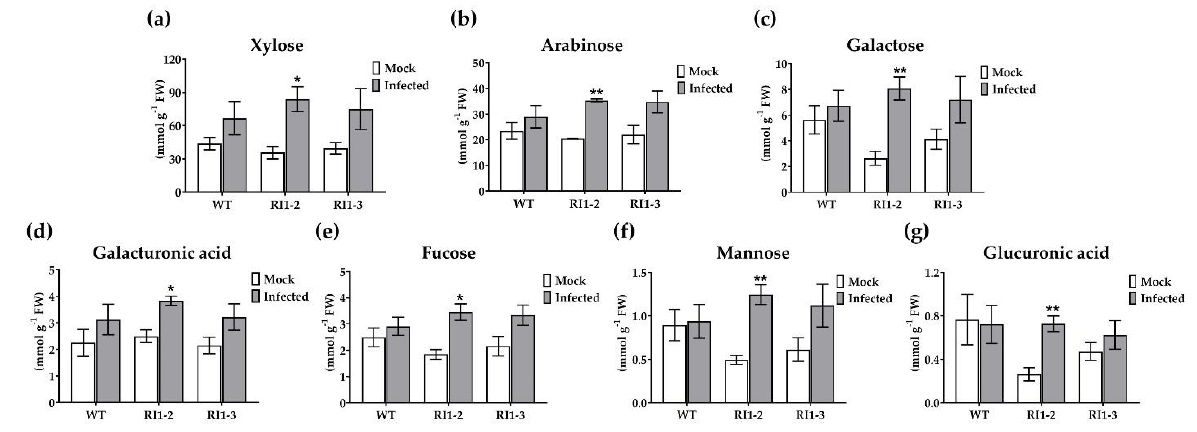
Xylose; ( b ) arabinose; ( c ) galactose; ( d ) galacturonic acid; ( e ) fucose; ( f ) mannose; ( g ) glucuronic acid. Data are presented as the mean ± standard error of three replicates. Asterisk indicates statistically t -test (* p < 0.05 and ** p < 0.01).